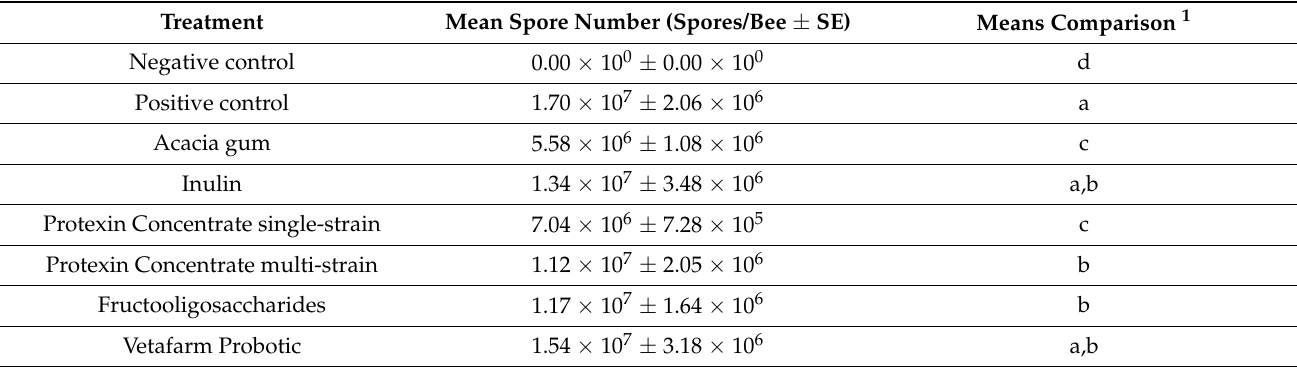
Table 2. Mean N. ceranae spore number per bee ± SE of non-infected (negative control) or infected bees fed sugar syrup (positive control) or sugar syrup containing prebiotics or probiotics. Treatment Mean Spore Number (Spores/Bee ± SE) Means Comparison 1 Negative